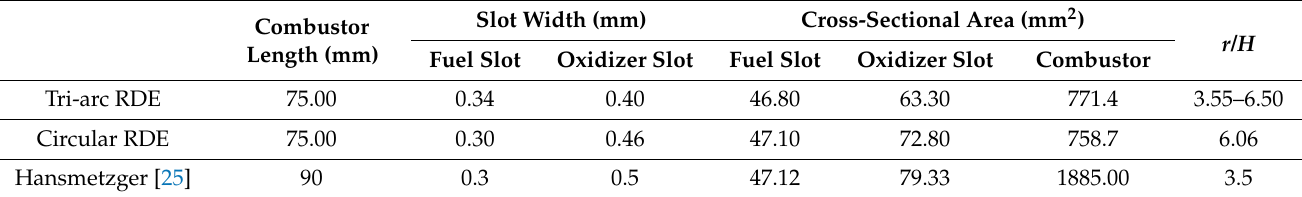
Table 1. Geometric dimensions for the tri-arc and circular RDEs.